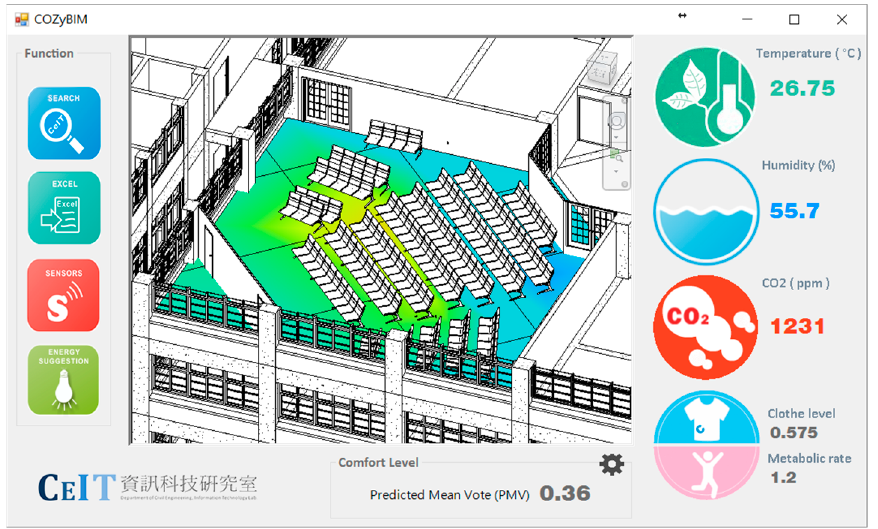
Figure 6. Graphical user interface of COZyBIM.